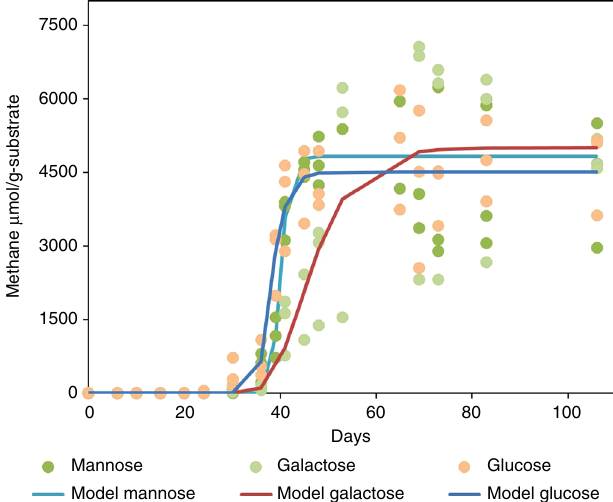
Fig. 4 Gompertz model and raw data points of the six-carbon carbohydrates. The six-carbon carbohydrates include mannose, galactose, glucose. The values of the peak methane galactose A = 6488, mannose A = 6019 and glucose A = 5041, the parameters µ m, and λ are displayed